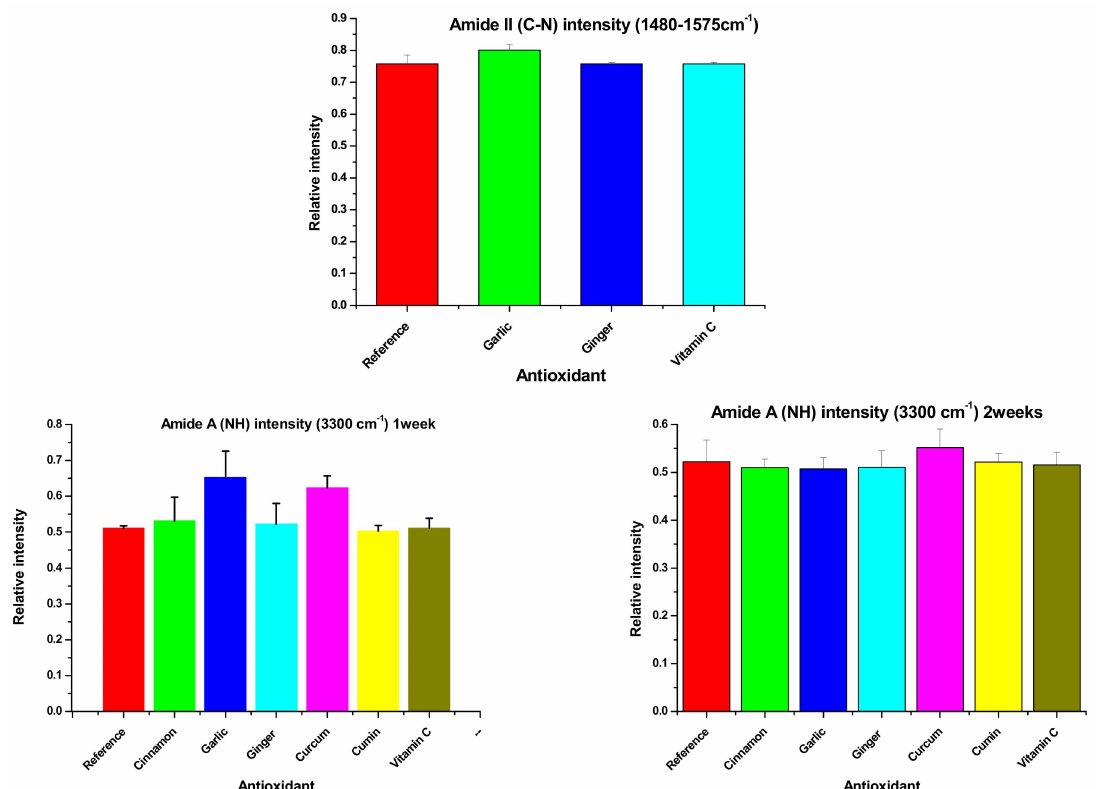
Figure 2. Amide-II (C-N) intensity (1480 − 1575cm − 1 ) after 1week, Amide-A (NH) intensity (3300 cm − 1 ) after 1week and 2weeks for antioxidant treated and non-treated minced fillets of Ehrenberg’s Snapper at − 25.0 ◦ C. Data are expressed as the mean ± SD, n =